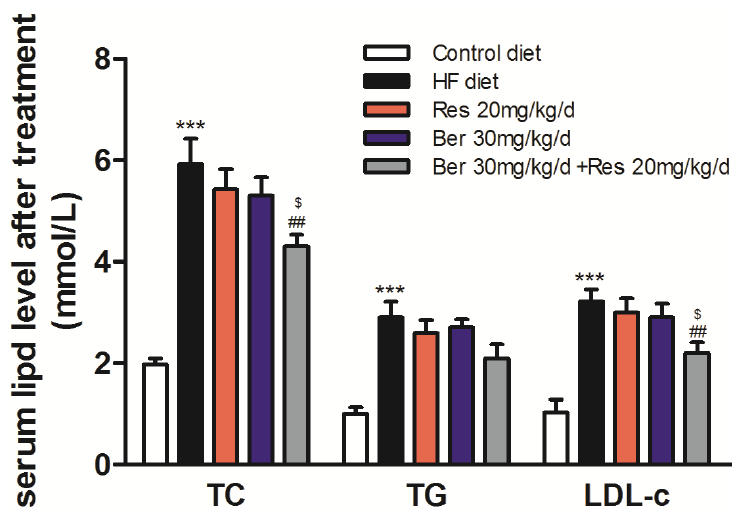
Figure 1. The lipid-lowering effect of Ber, Res and their combination in hyperlipidemic C57BL/6J mice. As Materials and methods mentioned, serums were isolated from mice after different drug treatments. The total cholesterol (TC), Triglyceride (TG) and LDL-cholesterol (LDL-c) levels were measured. Values are mean ± SD of all of mice in each group ( n = 8). *** p < 0.001 vs. that of the control low diet group; ## p < 0.01 vs. that of the HFD group; $ p < 0.05 vs. that of Ber or Res monotherapy. The result is a representative for three separate experiments.